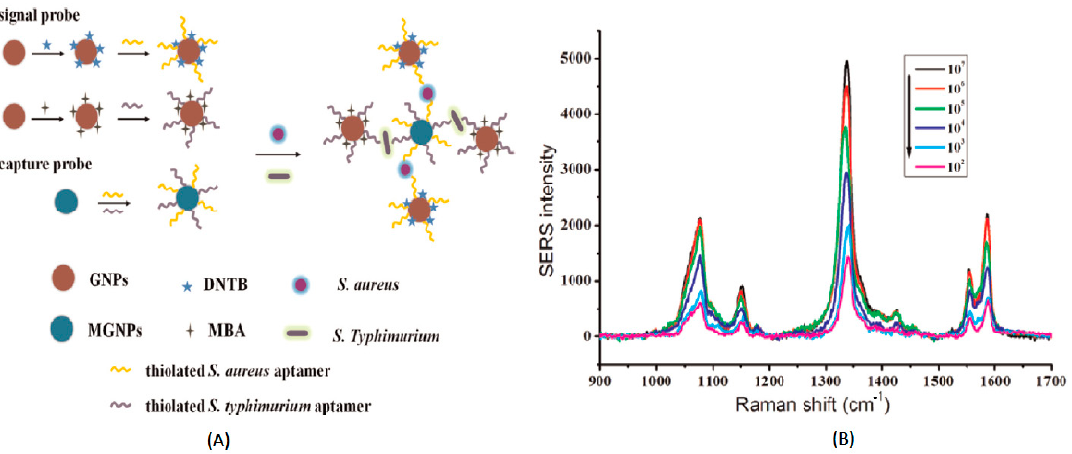
Figure 1. ( A ) Schematic illustration of the aptasensor, immobilized on Fe 3 O 4 magnetic Au nanoparticles (MGNPs) for the simultaneous detection of S. aureus and S. typhimurium , based on Au nanoparticles (GNPs) enhanced by Raman intensity. ( B ) Raman scattering spectra of different concentration of S. aureus and S. typhimurium (10 2 cfu mL − 1 , 10 3 cfu mL − 1 , 10 4 cfu mL − 1 , 10 5 cfu mL − 1 , 10 6 cfu mL − 1 , and 10 7 cfu mL − 1 ) (Zhang et al. [36] ).